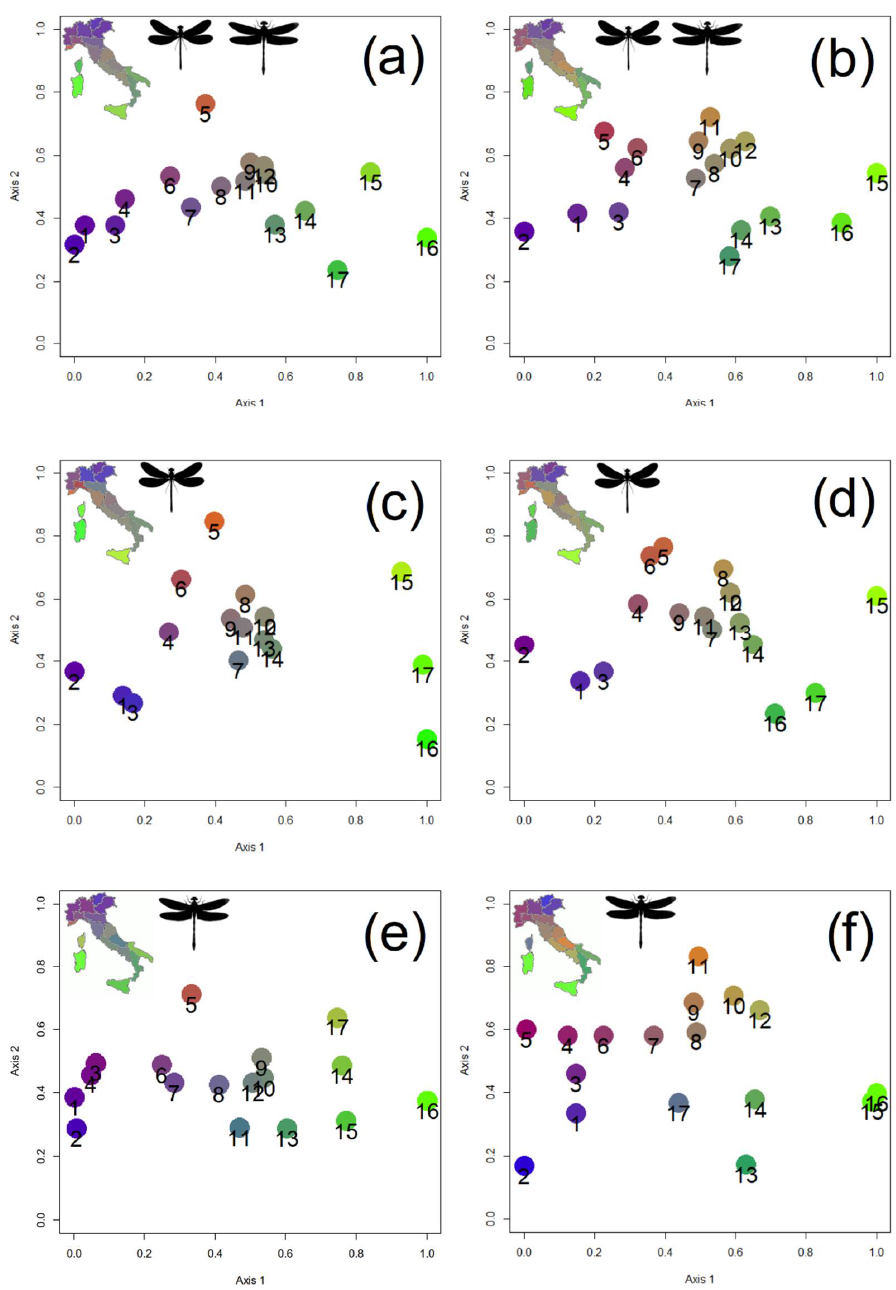
Figure 2. Biogeographical similarity among Italian regions expressed using Non-Metric Multidimensional Scaling (NMDS) on the Sørensen and Simpson indices based on odonate species composition: ( a ) NMDS for total odonates with the Sørensen index (Stress: 0.059); ( b ) NMDS for total odonates with the Simpson index (Stress: 0.117); ( c ) NMDS for Zygoptera with the Sørensen index (Stress: 0.058); ( d ) NMDS for Zygoptera with the Simpson index (Stress: 0.114); ( e ) NMDS for Zygoptera with the Sørensen index (Stress: 0.077); ( f ) NMDS for Zygoptera with the Simpson index (Stress: 0.116). Italian natural regions are numbered as in Figure 1a. NMDS conducted on the Zygoptera using the Sørensen (Figure 2c) and Simpson (Fig- ure 2d) indices were similar to those achieved for the entire order, but with Corsica closer